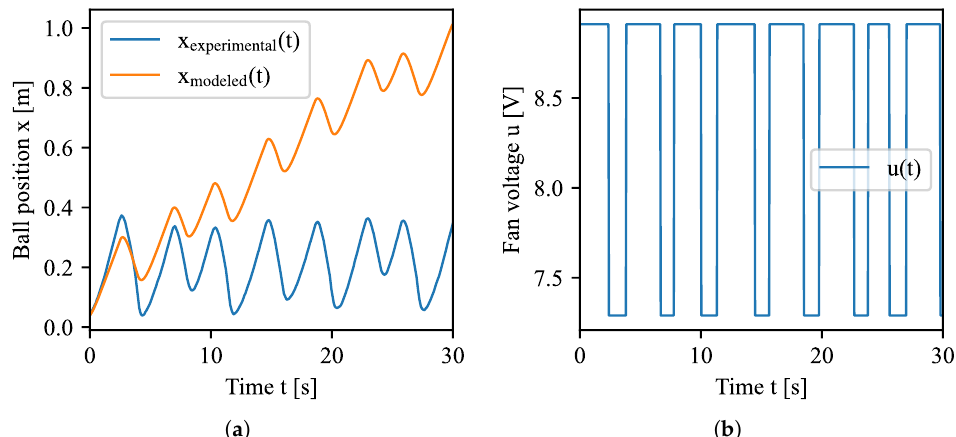
Figure 9. Validation of the ball in tube subsystem. ( a ) Real plant compared to modeled ball position x ( t ) ; ( b ) fan’s input voltage u ( t ) . Table 1. Estimated model